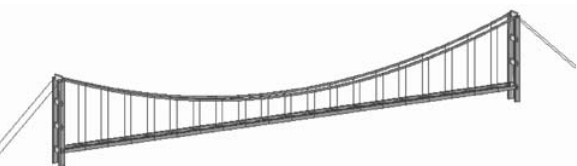
Fig. 1 . Finite element space model of the bridge